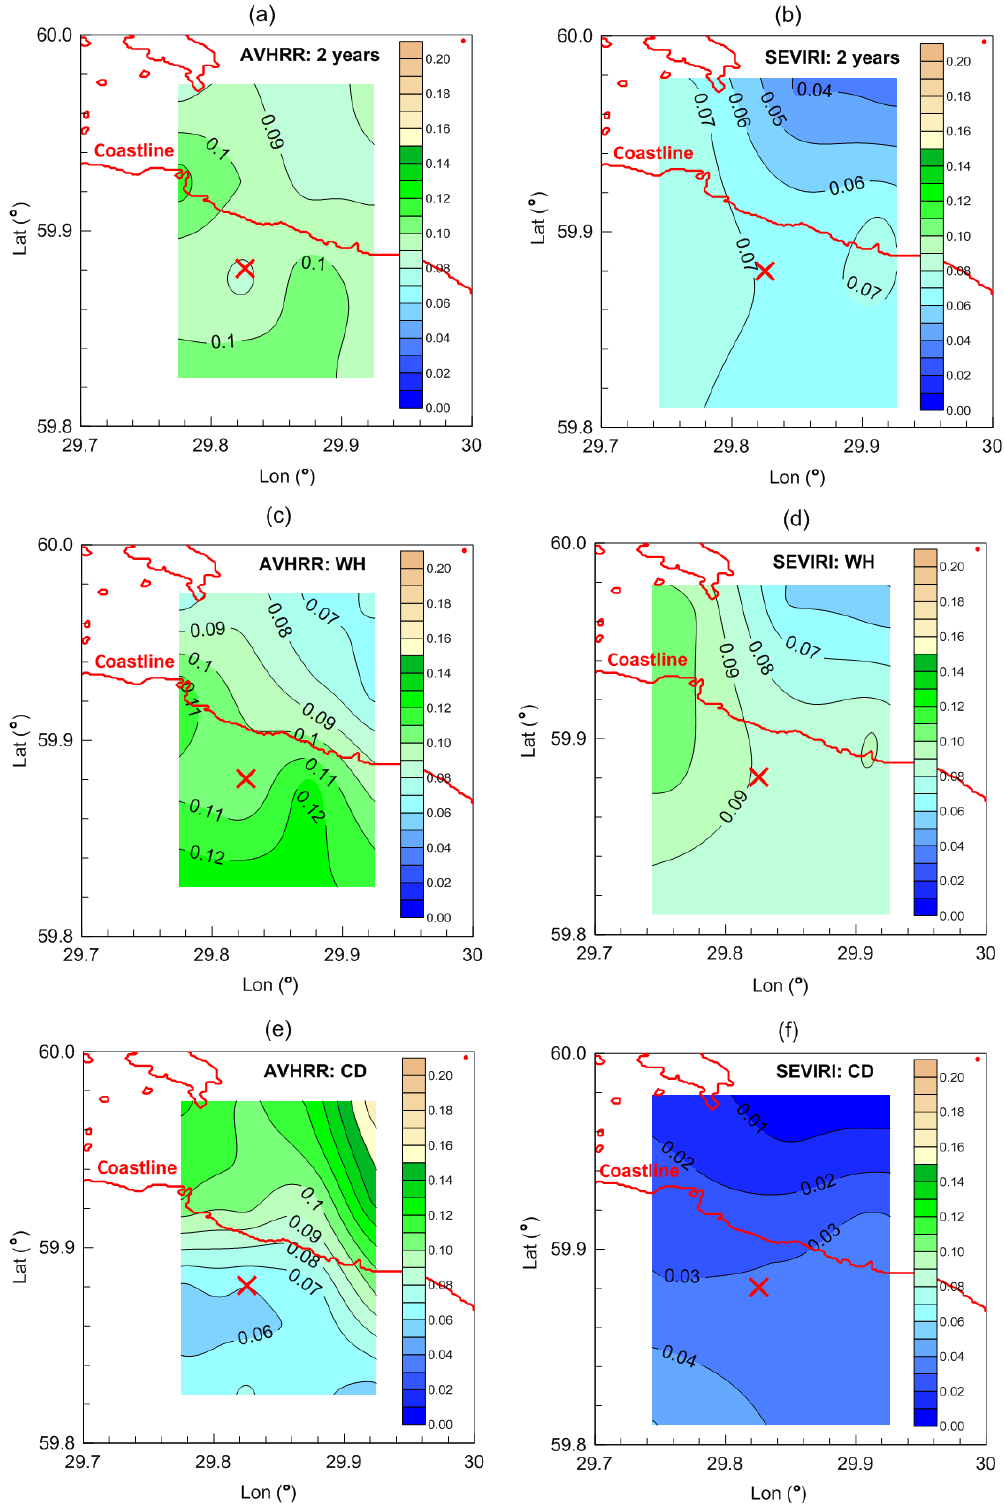
Figure 4. The map of the mean LWP values (kgm − 2 , colour scale) calculated for the small terrain and for the complete 2-year dataset (a, b) , the WH season (c, d) , and the CD season (e, f) : measurements by the AVHRR instrument (a, c, e) and the SEVIRI instrument (b, d, f) . The position of the HATPRO radiometer is marked by the red cross; the coastline is marked by the red line. Vector shoreline data: GSHHG